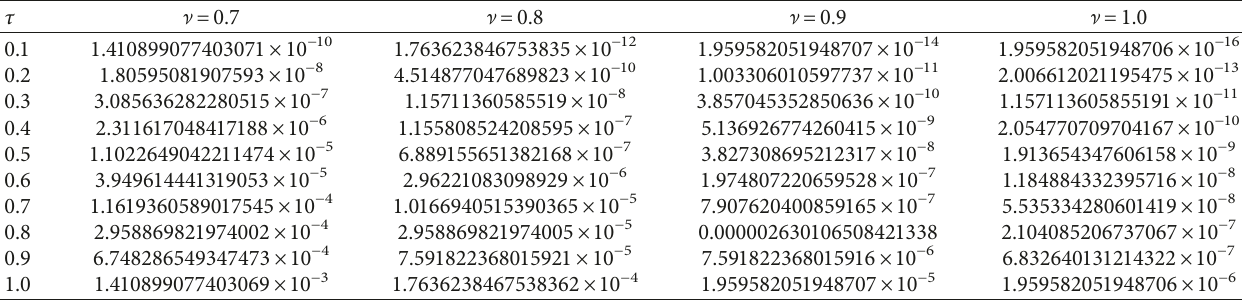
Table 11: The recurrence error of the 5th approximate solution of the real part in Example 4.